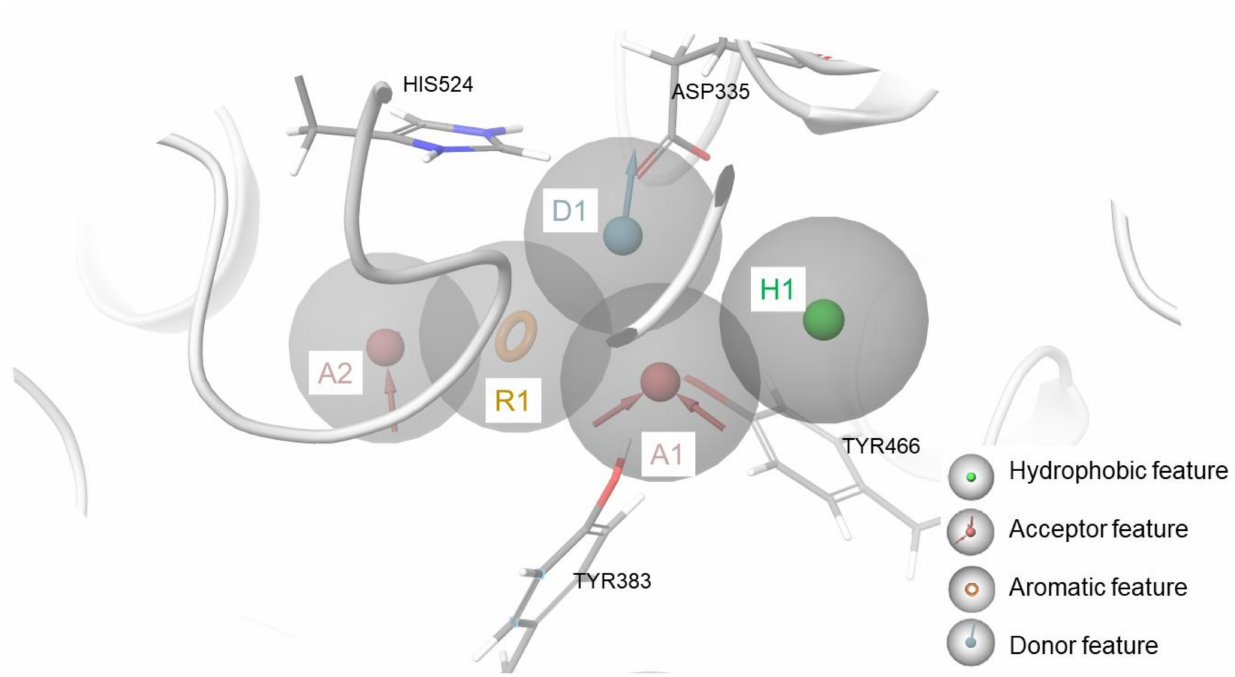
Figure 6. 3D structure-based pharmacophore model in the binding site of sEH (reference protein crystal structure featuring PDB code = 5AI5).